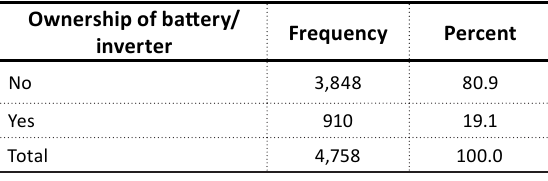
Table 15. Ownership of battery/inverter